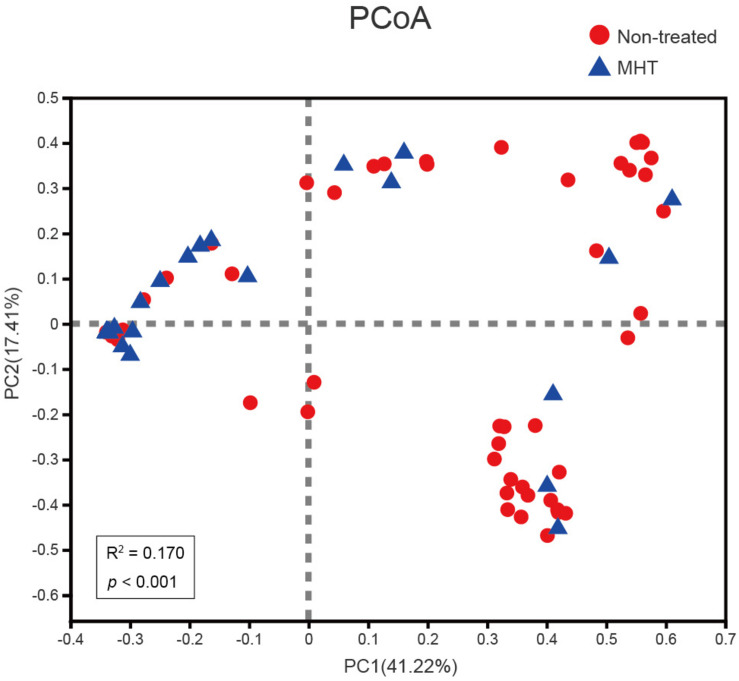
Comparing samples distributions belonging to the non-treated (red) or MHT (blue) group by using principal coordinate analysis (PCoA) on the Bray–Curtis dissimilarity. Each sample is shown as a dot.